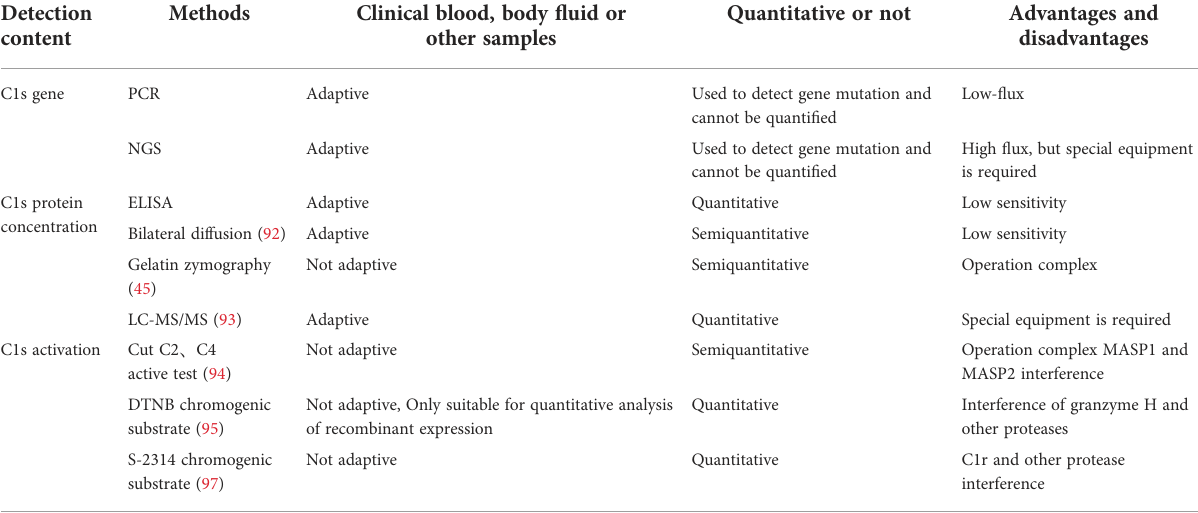
TABLE 2 Methodology, advantages, and disadvantages of complement C1s detection. Detection